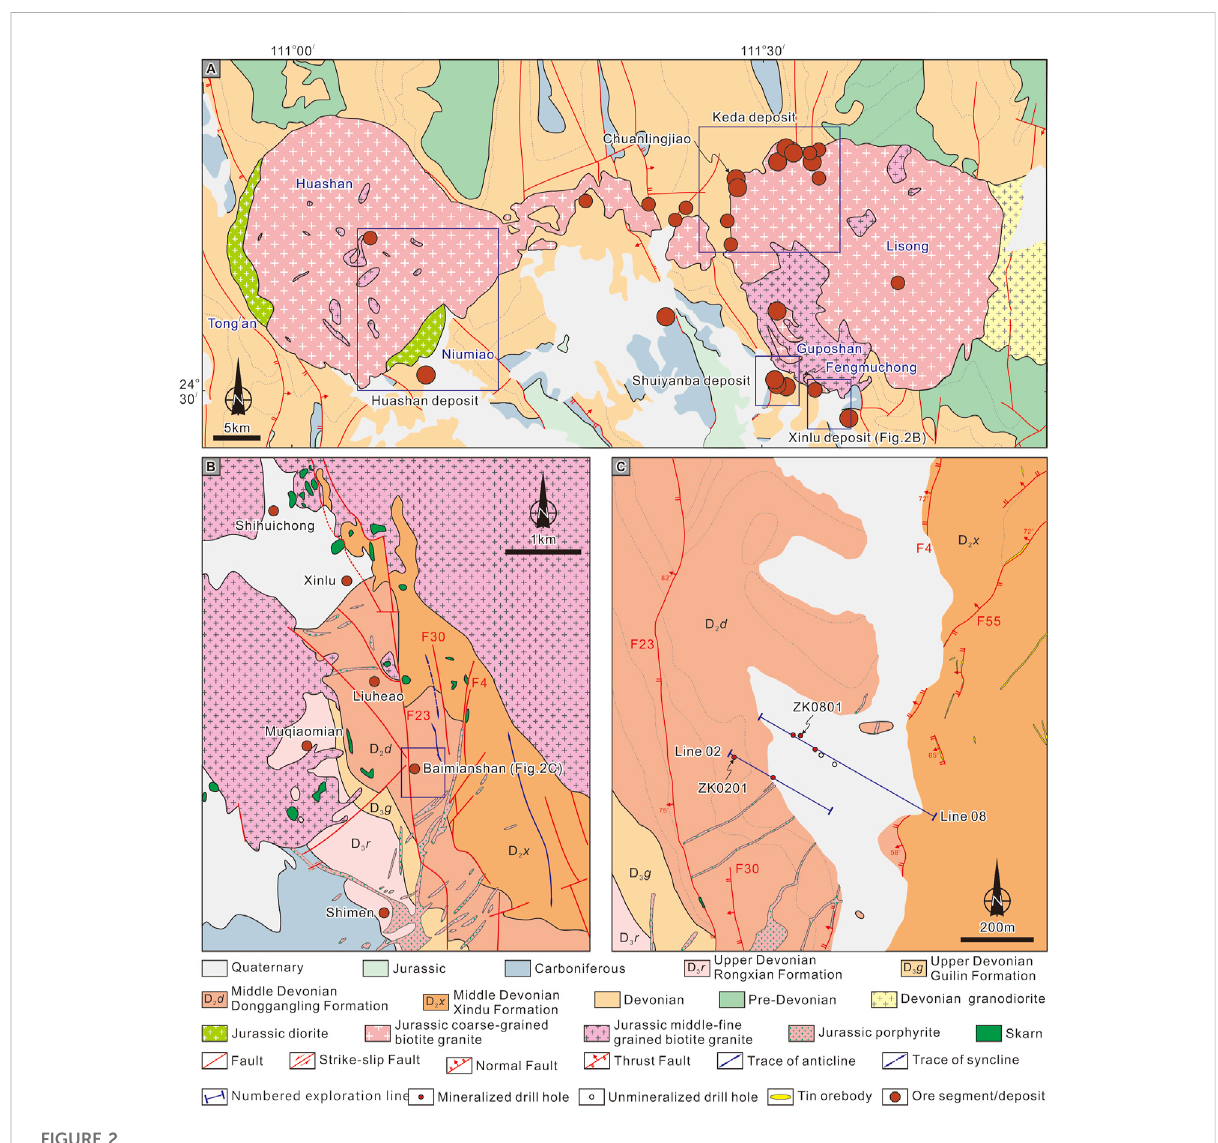
FIGURE 2 (A) Geological map of Guposhan-Huashan Sn-W district (modi fi ed after Geological Prospecting Institute of Guangxi (GPIG), 2021). (B) Geological map of Xinlu Sn-Zn deposit (modi fi ed after Feng et al., 2019). (C) Geological map of Baimianshan Zn-Sn segment (modi fi ed after GPIG,